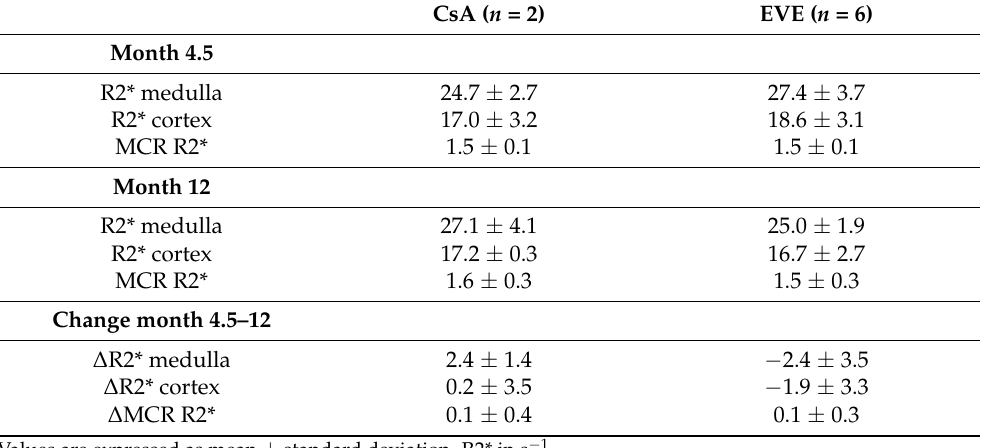
Table 5. BOLD-derived transverse relaxation rate according to medication group and time-point.